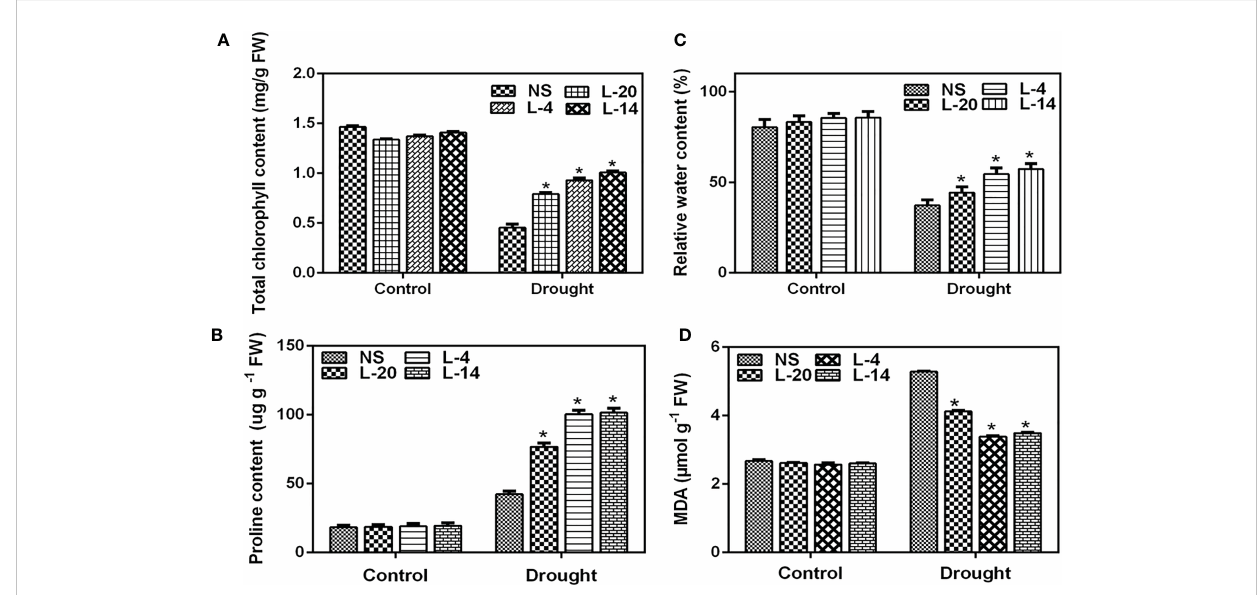
FIGURE 8 Effect of drought treatment on tobacco transgenics harboring VaDJI after 14 days of drought stress; (A) Estimation of total chlorophyll content, (B) Proline content, (C) RWC relative water content, (D) MDA levels in NS and transgenic tobacco lines. Data were represented as mean ± SE. Statistical signi fi cance was tested using one-way analysis of variance (ANOVA) and *(single asterisk) indicates p ≤